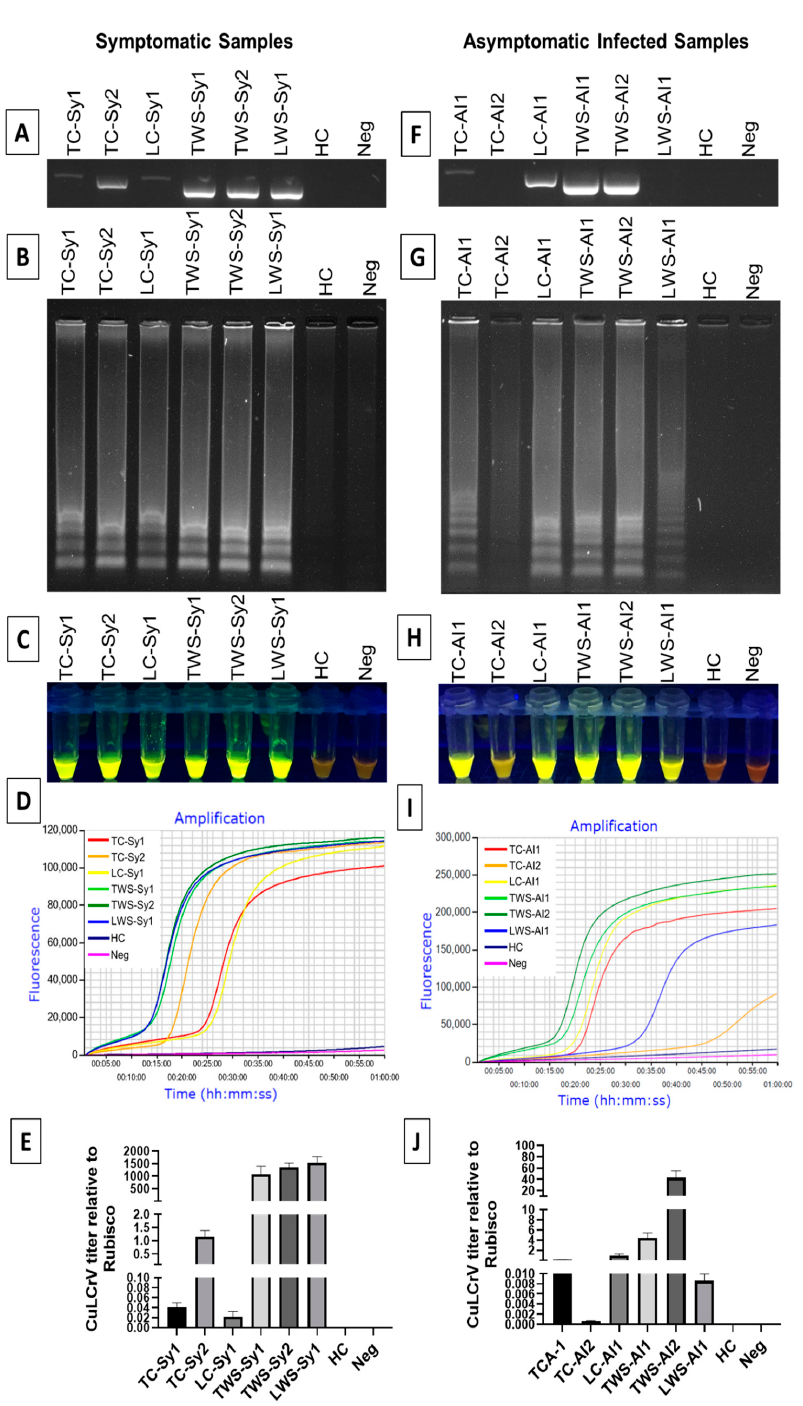
Figure 6. Detection of CuLCrV from symptomatic ( A – E ) and asymptomatic infected ( F , G , H , I , J ) cucumber and winter squash leaf samples using LAMP ( B – D , G – I ), PCR ( A , F ) and qPCR ( E , J ).